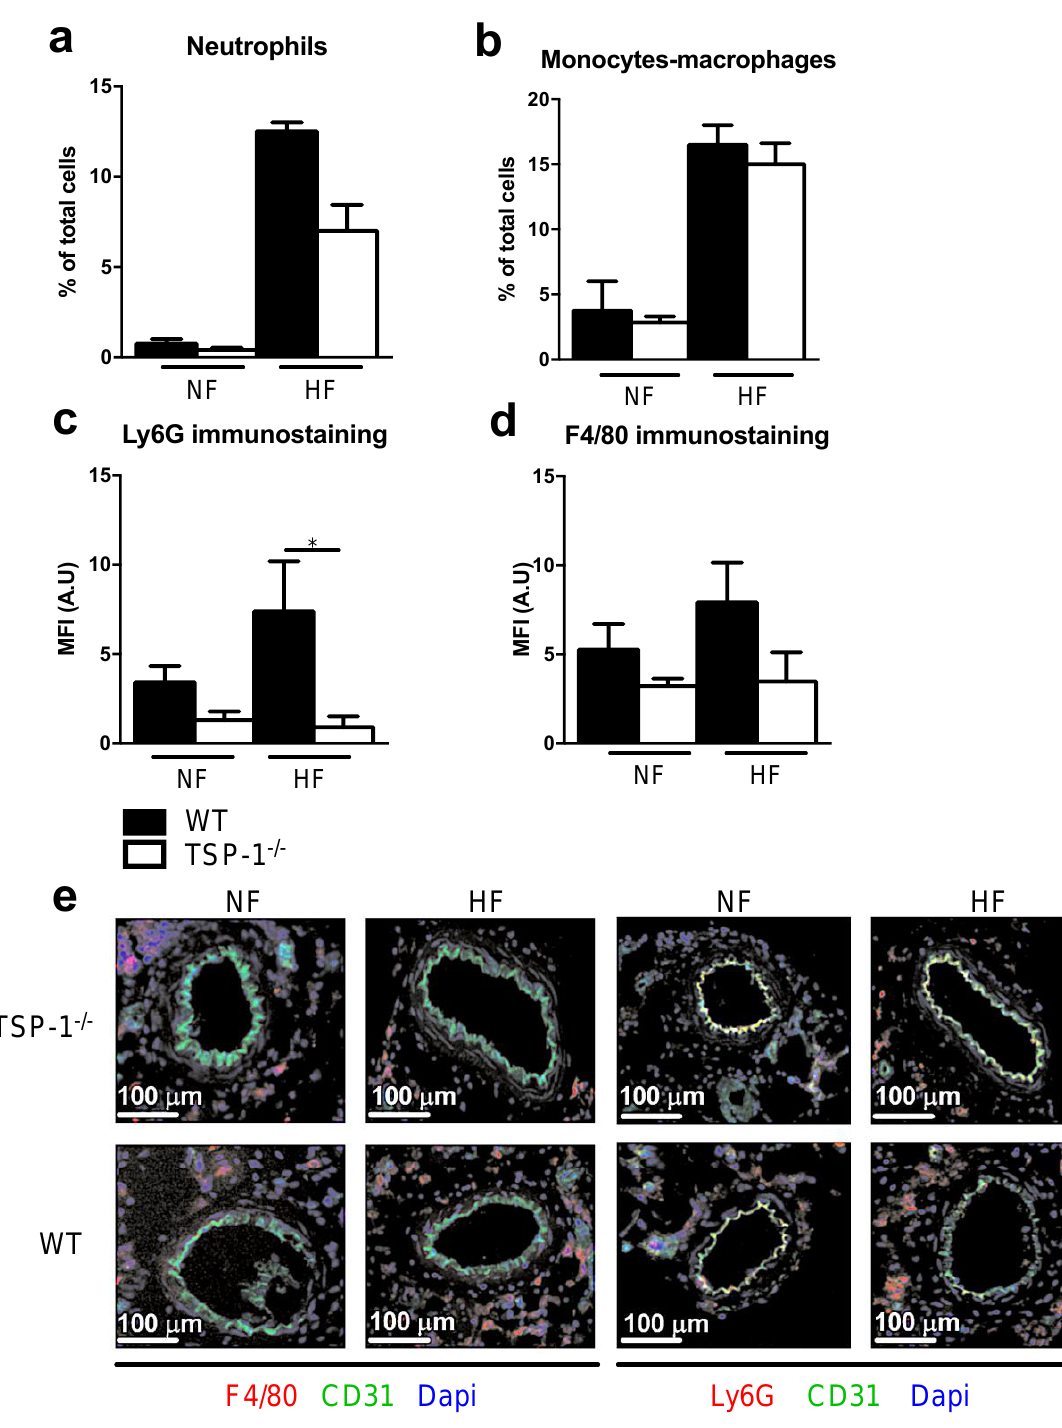
Figure 4. Immune cells recruitment in WT and TSP-1 − / − mesenteric arteries after four days of chronic increase in blood flow. Immune cells recruitment study with flow cytometry experiment (WT n = 2, TSP-1 − / − n = 6) results showing neutrophils ( a ) and monocyte and macrophages ( b ) proportion. Mean fluorescence intensity (MFI) quantification of neutrophils ( c ) and macrophages ( d ). ( e ) Representative pictures of mesenteric arteries section immunostained with anti F4/80-PE, anti Ly6G- PE, anti CD31-FITC antibodies and DAPI, magnification × 10, scale bar = 100 µ m (WT n = 7, TSP-1 − / − n = 7). In all results, WT are represented in black and TSP-1 − / − in white. All results are expressed in means ± sem. * p < 0.05, WT vs. TSP-1 − / −